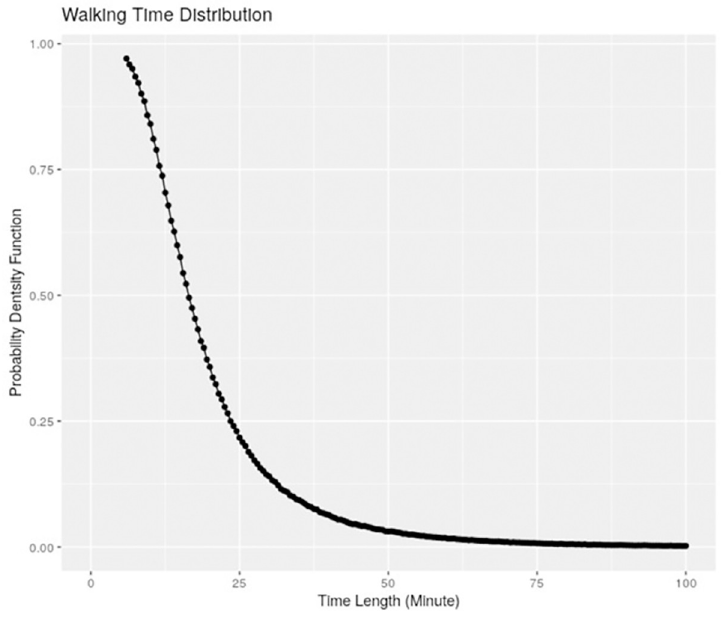
Fig 6. Walking Distribution of Labelled Sessions during Daily Living. Steady walking sessions only for included participants.